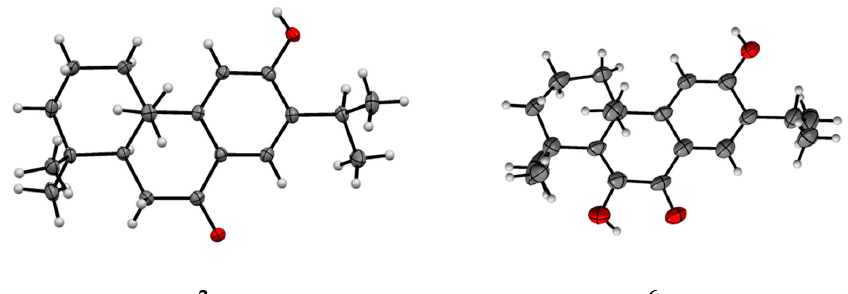
Figure 4. Crystal structure representations of compound 3 and 6 . The structure of 6 was deposited with the Cambridge Crystallographic Data Centre (CCDC) code 1900758.